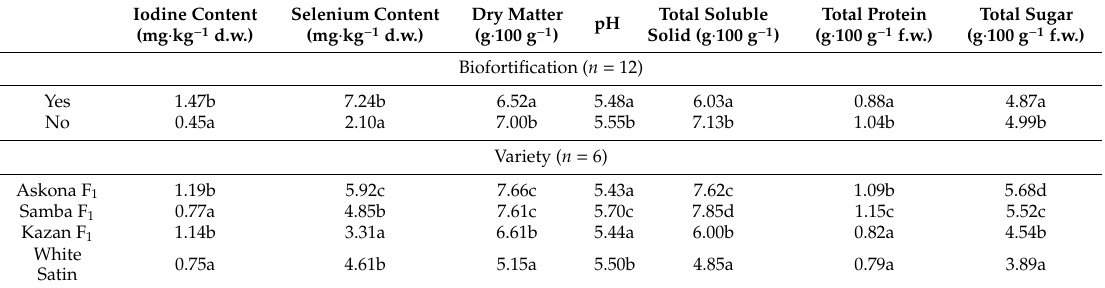
Table 1. Physicochemical parameters of carrot juice depending on carrot biofortification and their varieties. Iodine Content (mg · kg − 1 d.w.)